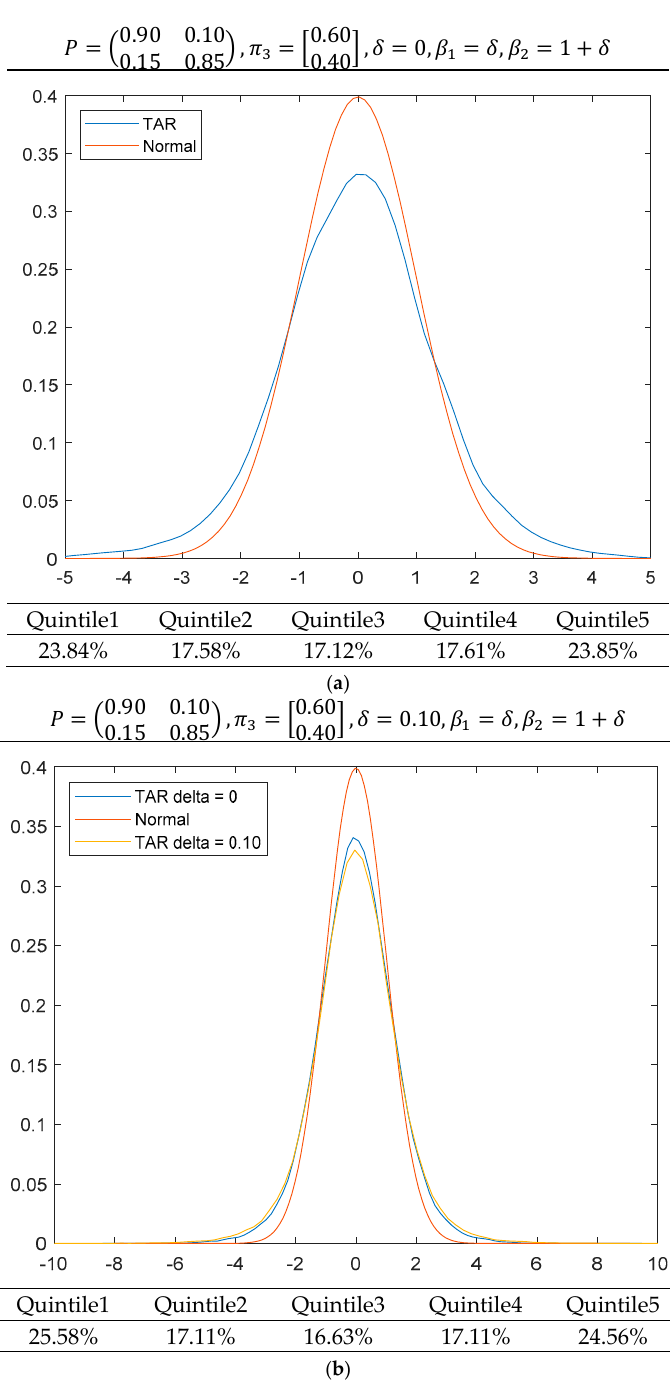
Figure 5. ( a ) Simulated Distributions for TAR(1) with 𝜋 (cid:2871) as the steady state vector and 𝛿 = 0 . ( b ) Simulated Distributions for TAR(1) with 𝜋 (cid:2871) as the steady state vector and 𝛿 = 0.10 .